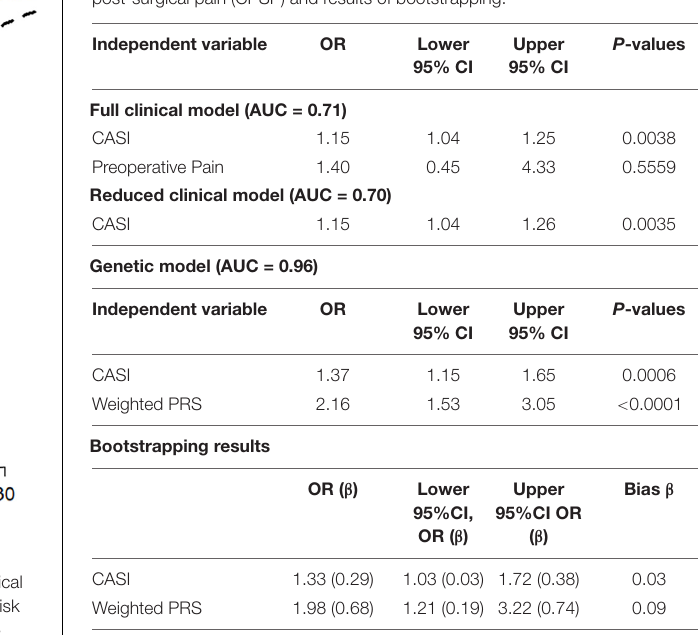
TABLE 3 | Multiple regression models evaluated for prediction of chronic post-surgical pain (CPSP) and results of bootstrapping.